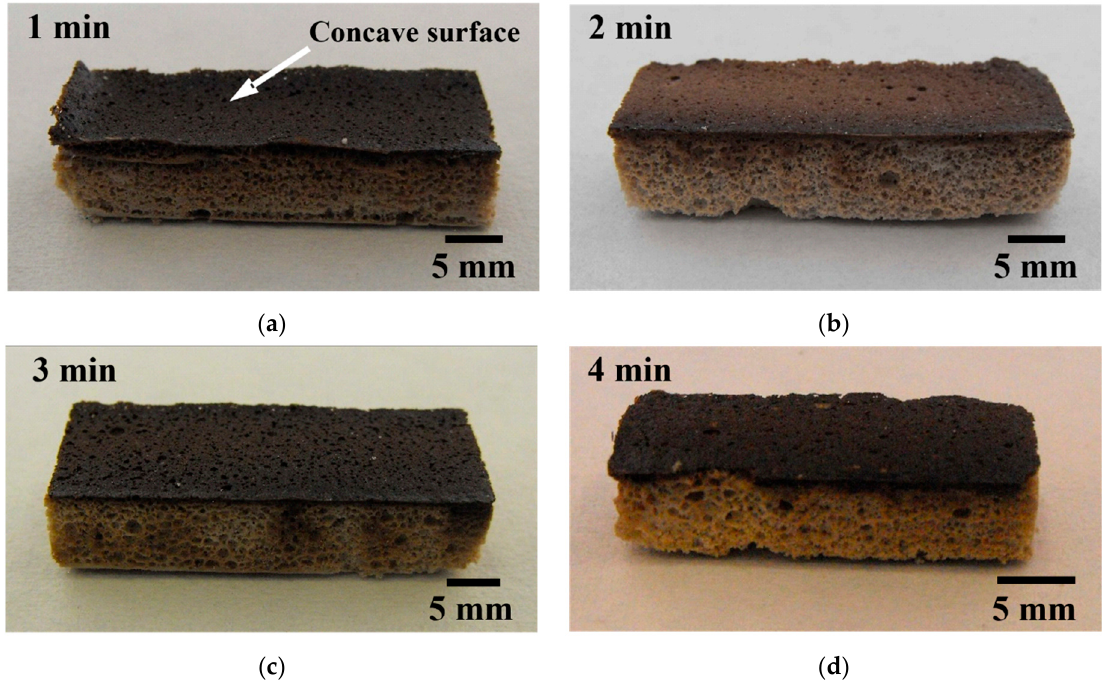
Figure 8. Effect of the stirring time on the macro characteristics of the MgAl 2 O 4 foams. ( a ) 1 min; ( b ) 2 min; ( c ) 3 min; and ( d ) 4 min.